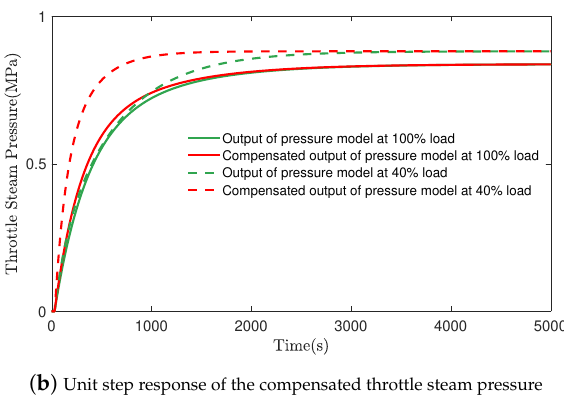
Figure 7. Unit step response of the compensated burning carbon and throttle steam pressure model at different